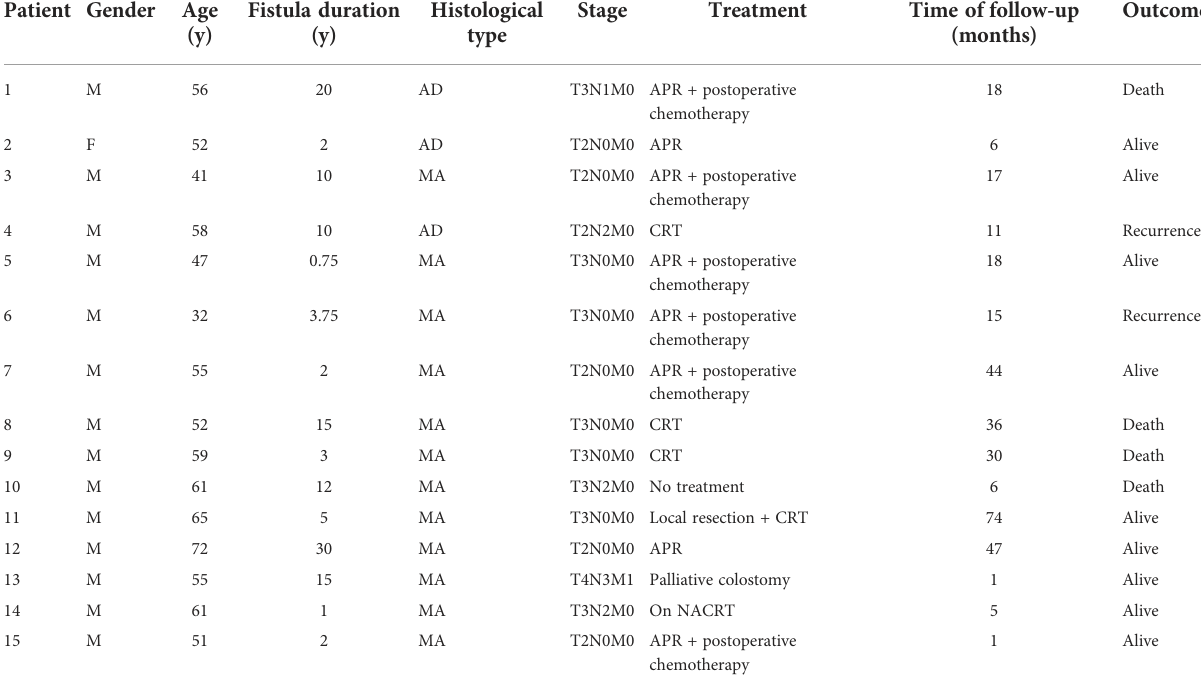
TABLE 1 Fistula-associated anal adenocarcinoma in 15